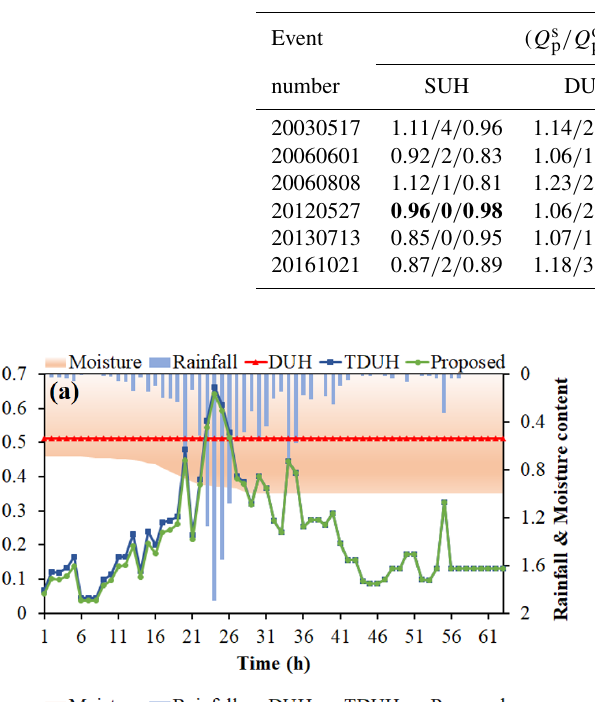
Table 7. Comparison of four routing methods for the Longhu River basin. The values in bold mean the result performed the best among the four methods.